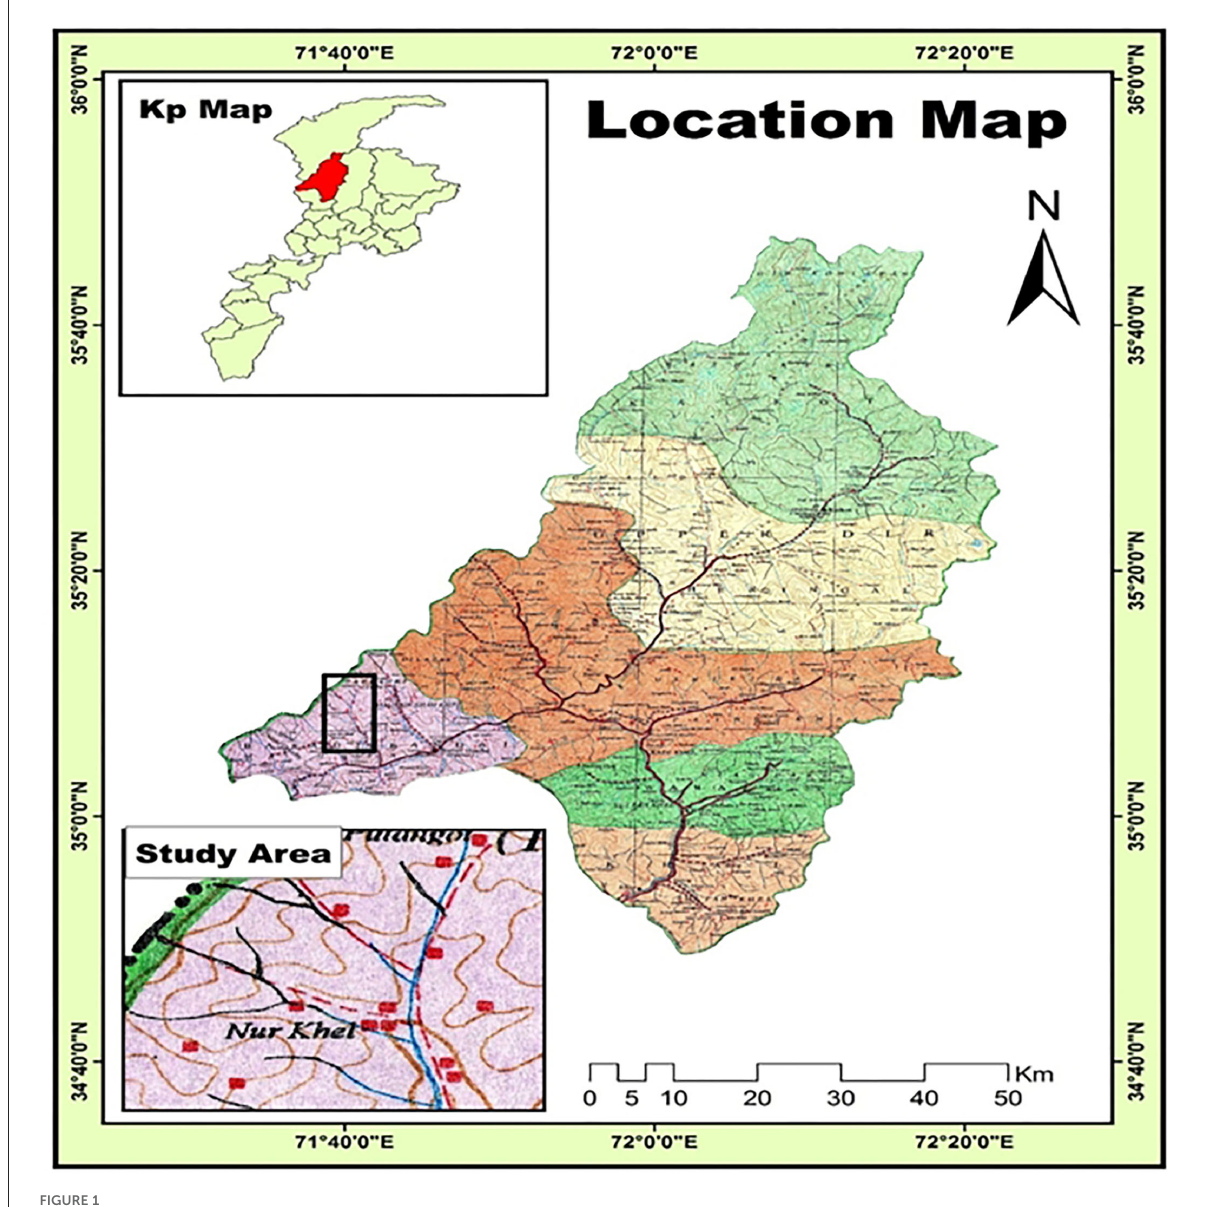
FIGURE1 Map showing Bin Dara, western boundary of